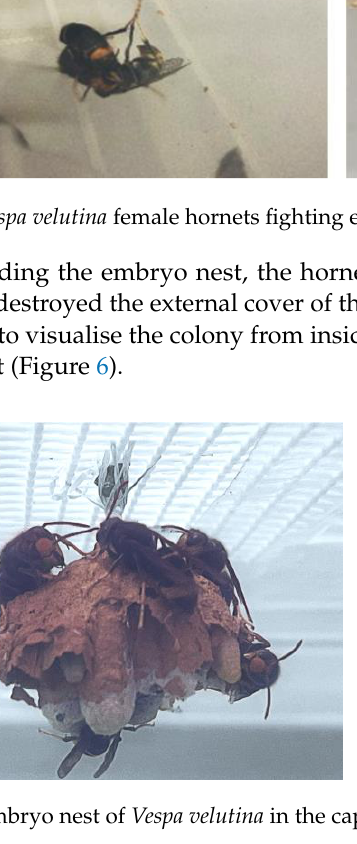
Figure 4. Adult Vespa velutina hornet removing a larva from the nest, with another previously removed larva.